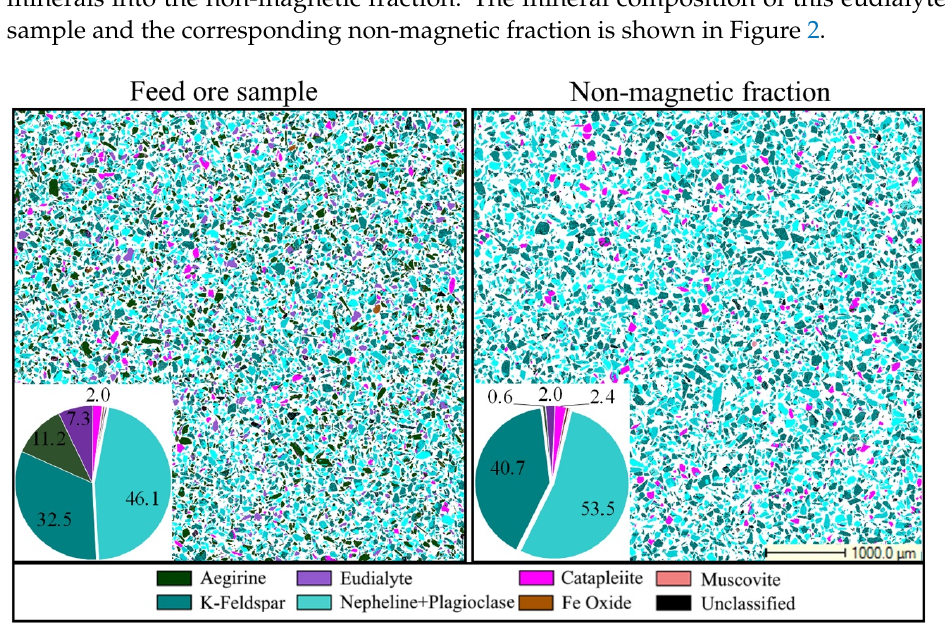
Figure 2. Detailed section views and modal composition of the eudialyte ore sample and non-magnetic fraction.